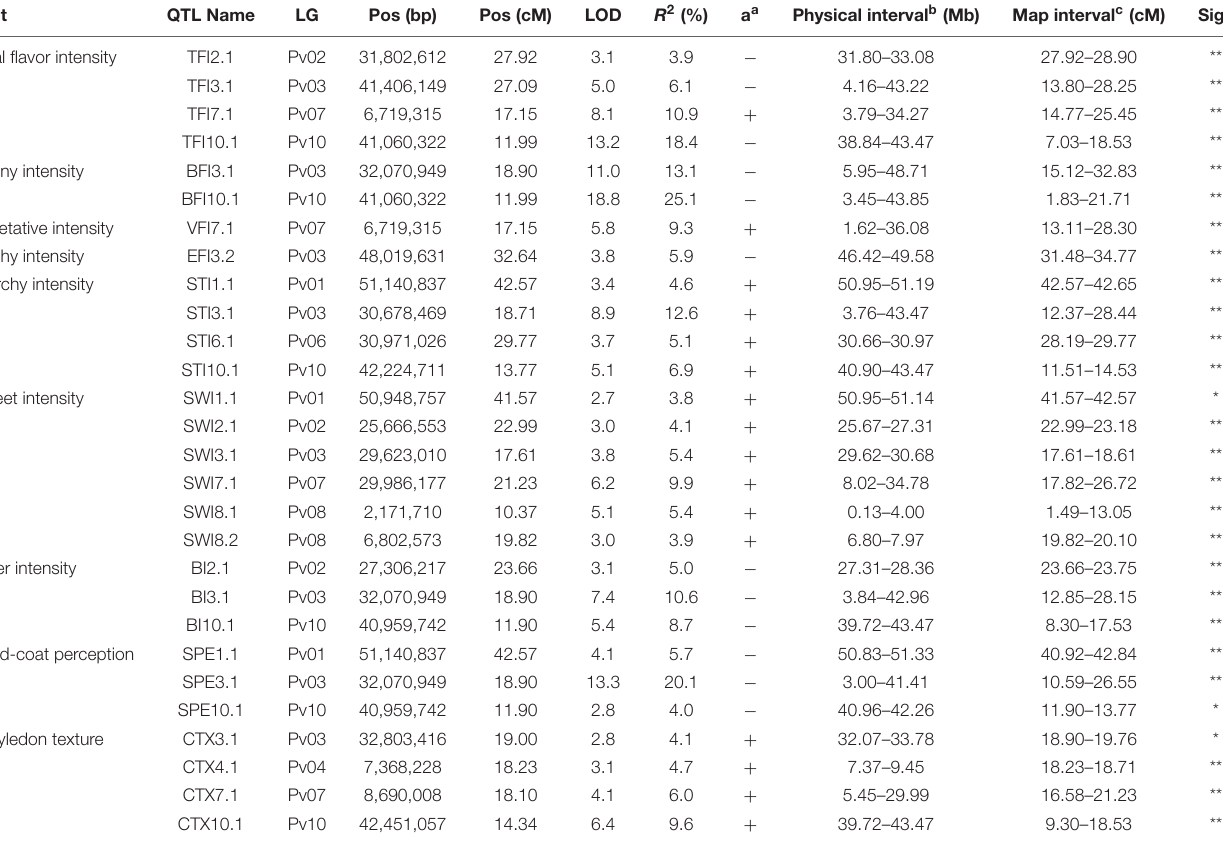
TABLE 4 | Quantitative trait loci identified in the RIL population ( N = 242) using BLUPs from samples grown in Entrican, MI in 2016 and 2017 for sensory attributes. Linkage group (LG), year, peak position (Pos), logarithm of odds (LOD), R 2 , QTL effect (a), physical interval, map interval, and significance of the QTL are indicated.